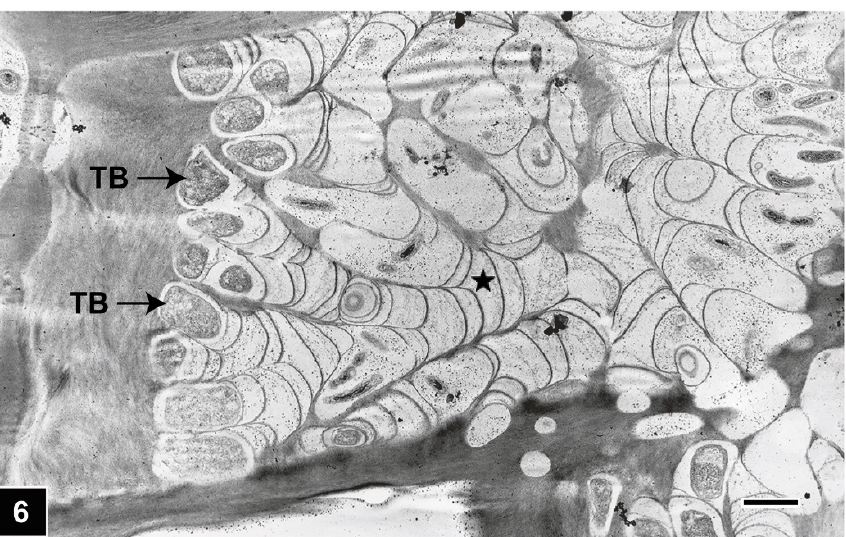
Figure 6. TEM of a glancing section through part of a wood cell wall attacked by tunnelling bacteria (TB). Tunnels display repeated branching (asterisk) radiating from a central point. Scale bar = 2 µm. The image is reproduced from Singh et al. (2016) Secondary Xylem Biology, Elsevier.